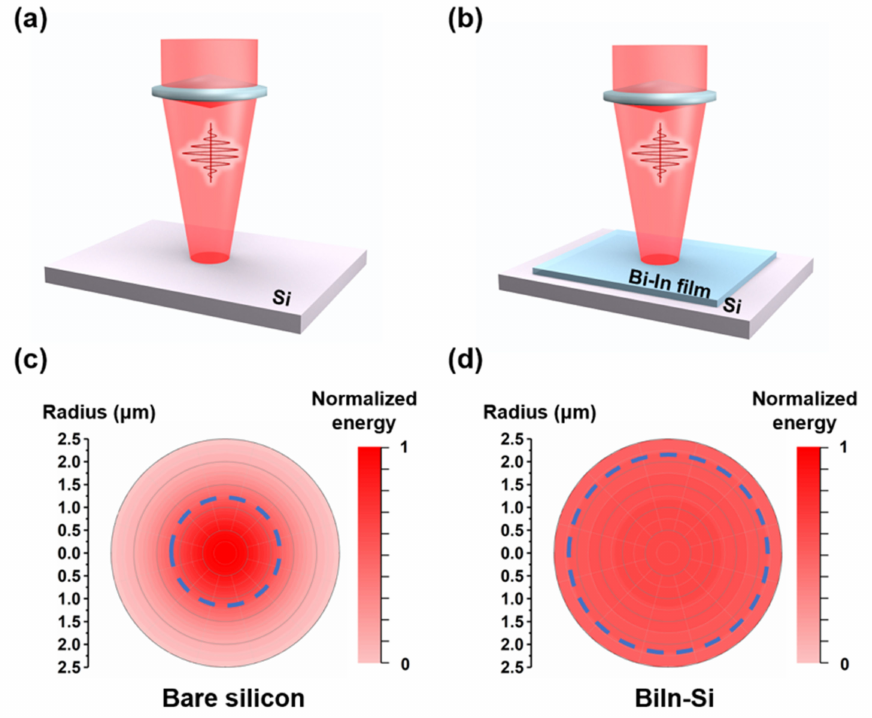
Figure 4. Schematic diagrams of the laser irradiation on samples. The laser beam was incident on the bare silicon ( a ) and on BiIn-Si ( b ). A sketch diagram of the energy distribution on bare silicon ( c ) and BiIn-Si ( d